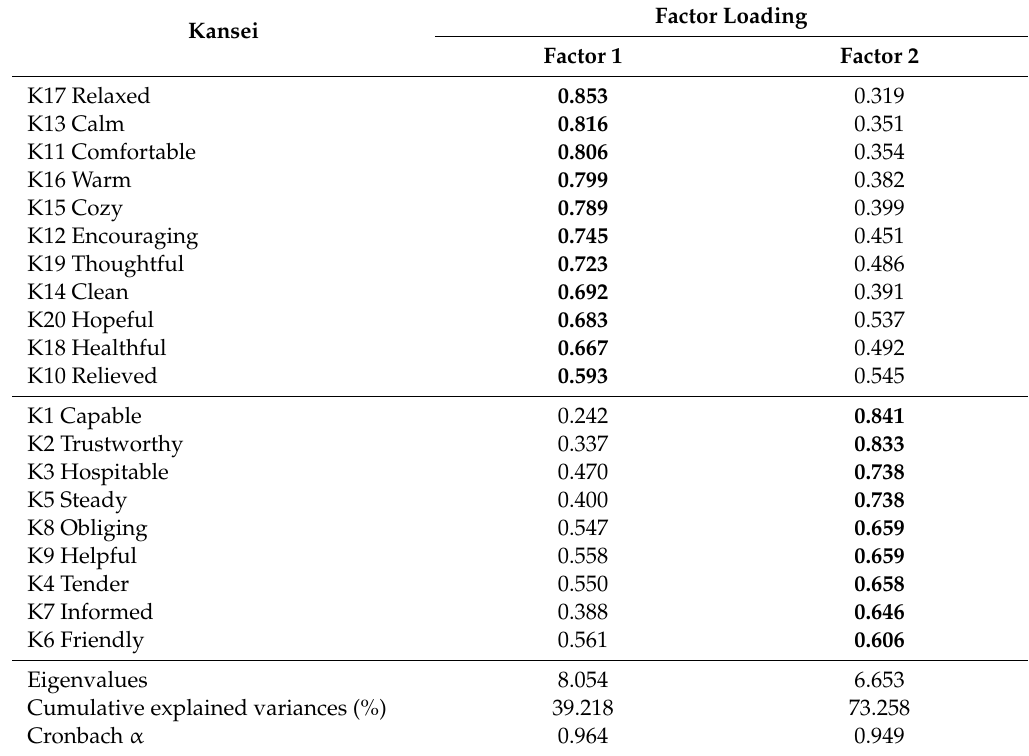
Table 3. Factor analysis of Kansei